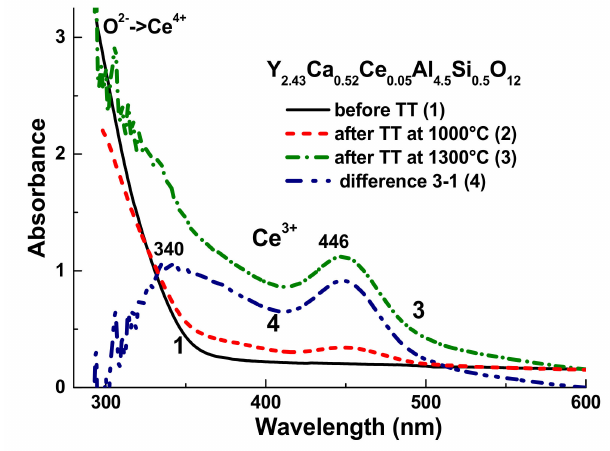
Figure 10. Influence of the TT in N 2 95% + H 2 5% atmosphere at 1000 ◦ C (2) and 1300 ◦ C (3) temperatures on the absorption spectra of Y 2.43 Ca 0.52 Ce 0.05 Al 4.5 Si 0.5 O 12 SCF. Curve 4 is the difference spectra of untreated and annealed samples at temperature of 1300 ◦ C. The annealing of Y 2.43 Ca 0.52 Ce 0.05 Al 4.5 Si 0.5 O 12 SCF in a reducing environment causes